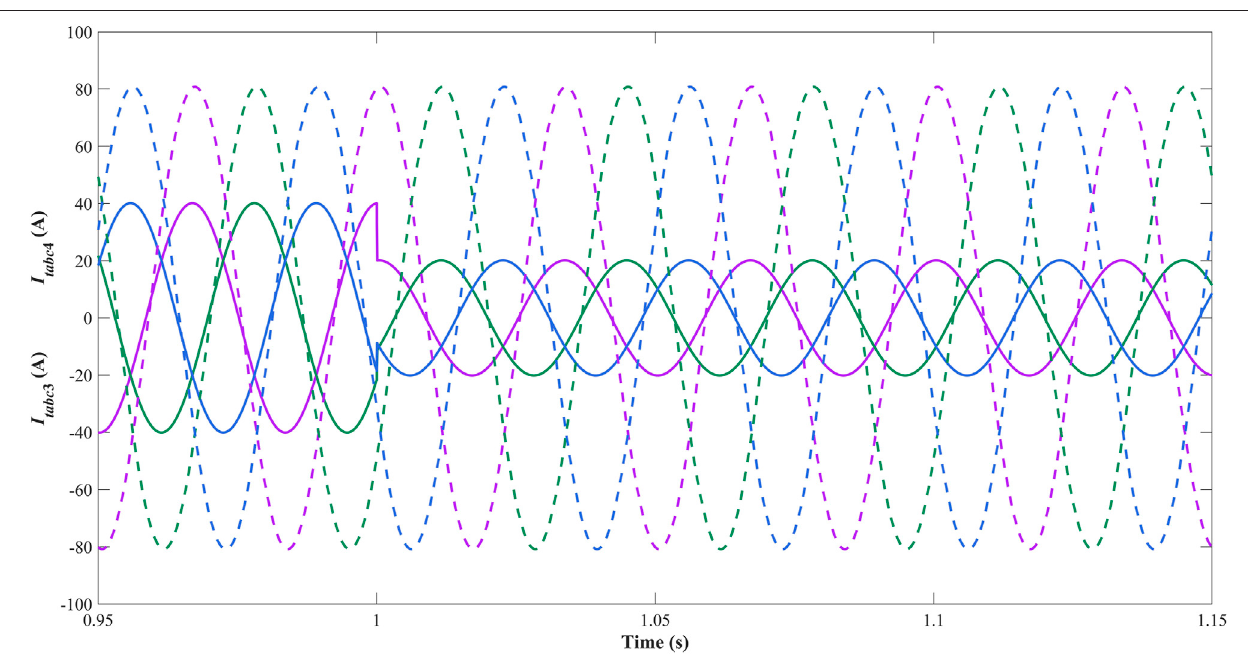
FIGURE 9 | Three-phase waveforms of currents generated from DGu3 and DGu4.